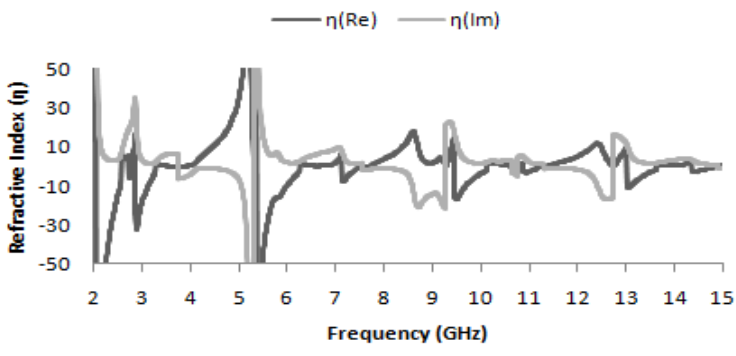
Figure 5. Real and imaginary values of refractive index (η) vs. frequency.